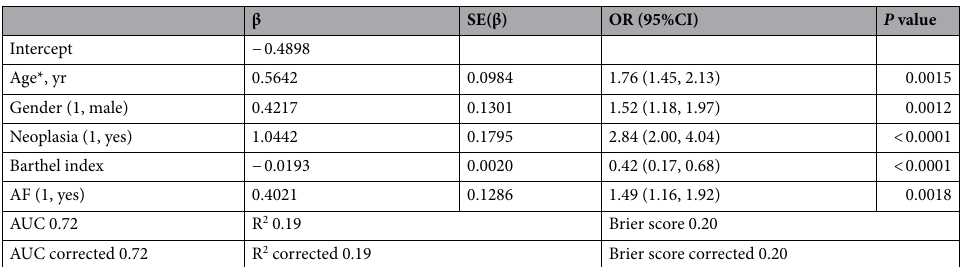
Table 3. Multivariate logistic regression analysis. Model with the 5 variables to estimate 1-year mortality risk. β indicates coefficient; SE, standard error; OR, Odds ratio; CI, 95% confidence interval; *, OR (95%CI) are shown for age interval between 74 and 87 years; AF, Atrial fibrillation; AUC, Area under the ROC